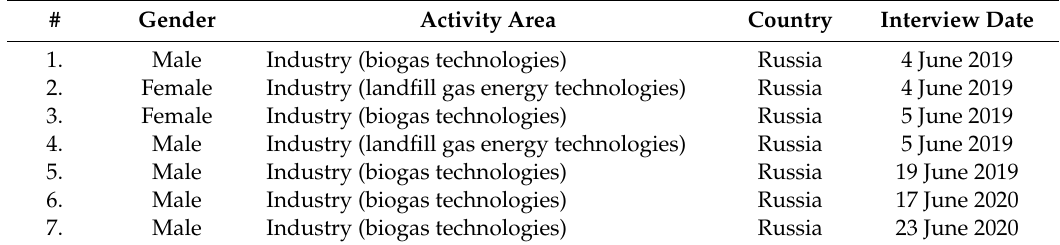
Table A4. Profiles of individuals who participated in the